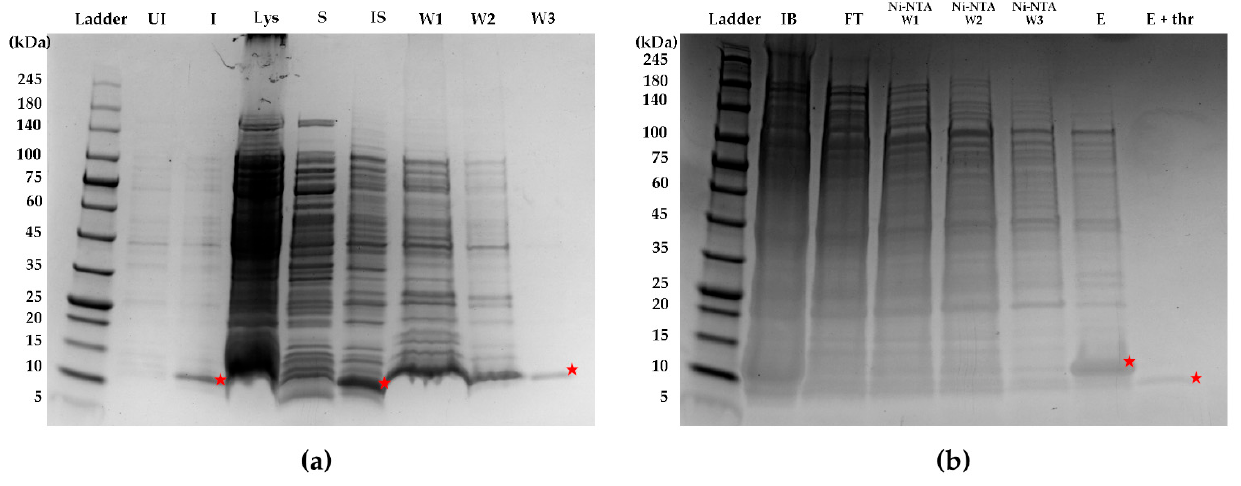
Figure 1. Sodium dodecyl sulfate-polyacrylamide gel electrophoresis (SDS-PAGE) of the process of rFasxiator N17R, L19E expression and purification. ( a ) Lane 1: protein ladder (Ladder), Lane 2: bacteria